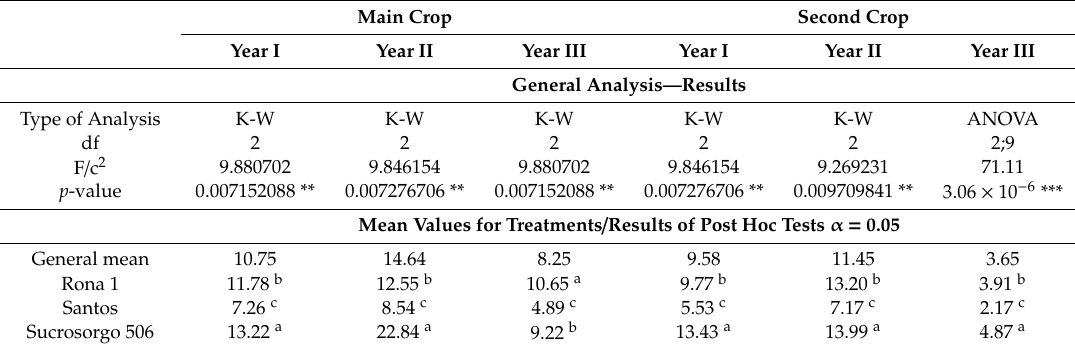
Table 6. Statistical analysis of bioethanol yield per hectare from sorghum